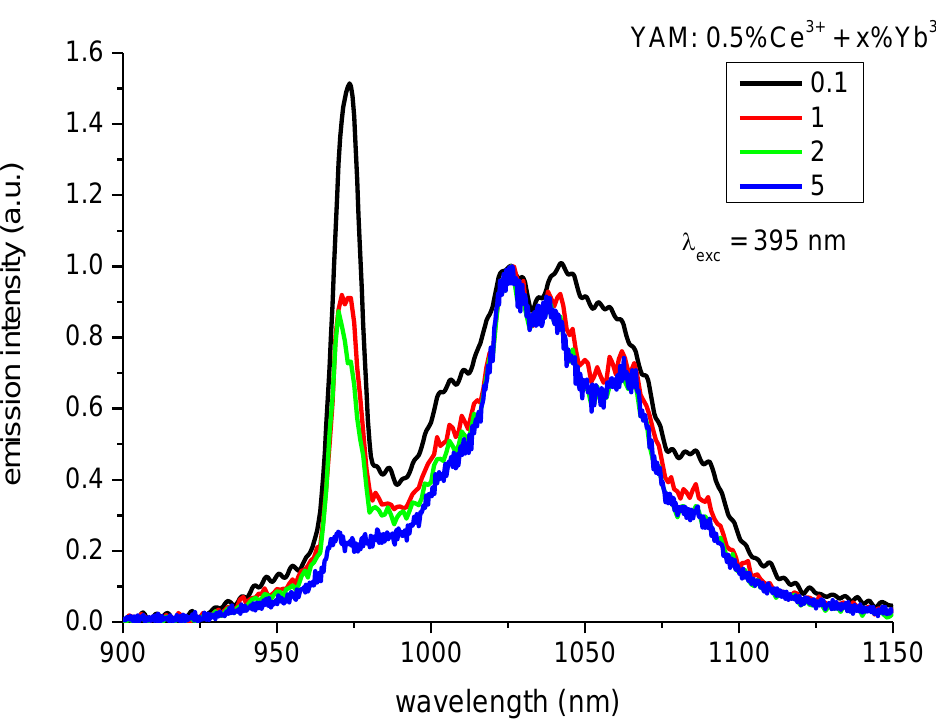
Figure 6. Emissions in the NIR range of Yb 3+ ions excited at 395 nm. With increased Yb 3+ concentra- tion the relative intensity of peak at about 980 nm decreases due to reabsorption.